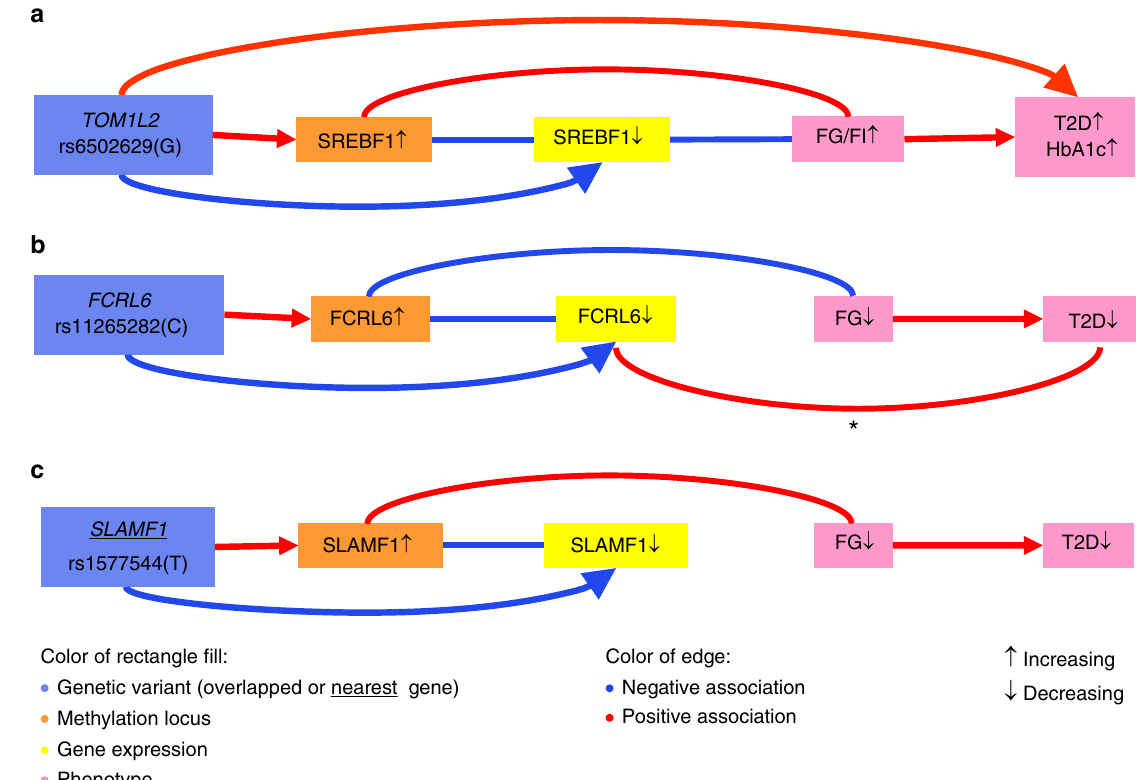
Fig. 3 The cross-omics integration of CpGs in SREBF1 ( a ), FCRL6 ( b ) and SLAMF1 ( c ). Cascading associations cross multi-omics were integrated in the network. * The association happens in the FCRL6 expression in liver. All other differential methylation or gene expression was measured in blood. FG fasting glucose, FI fasting insulin, T2D type 2 diabetes, HbA1c hemoglobin